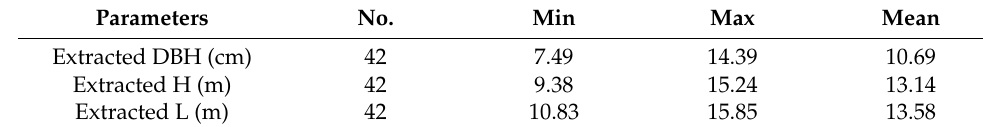
Table 2. Statistics of the extracted DBHs, Hs, and Ls of individual Moso bamboos.